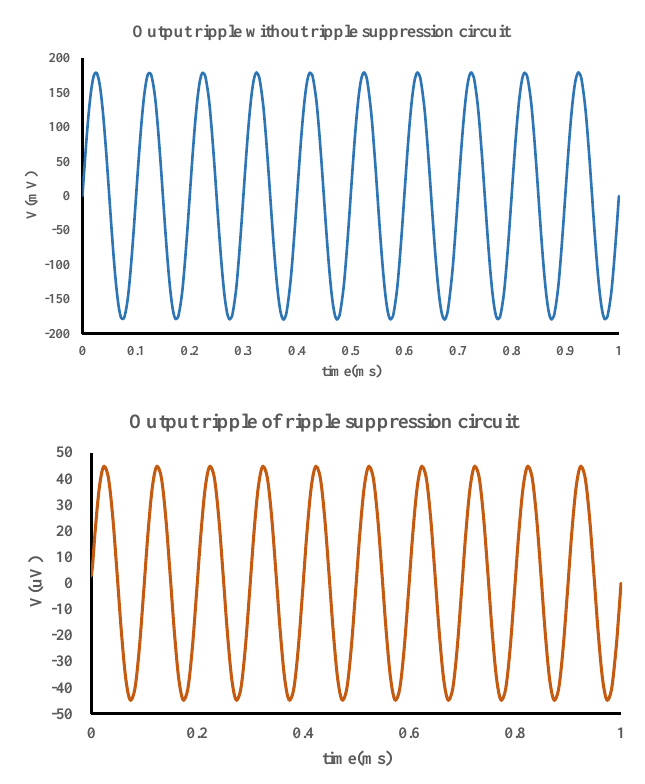
Figure 7. The output result of the ripple suppression circuit.